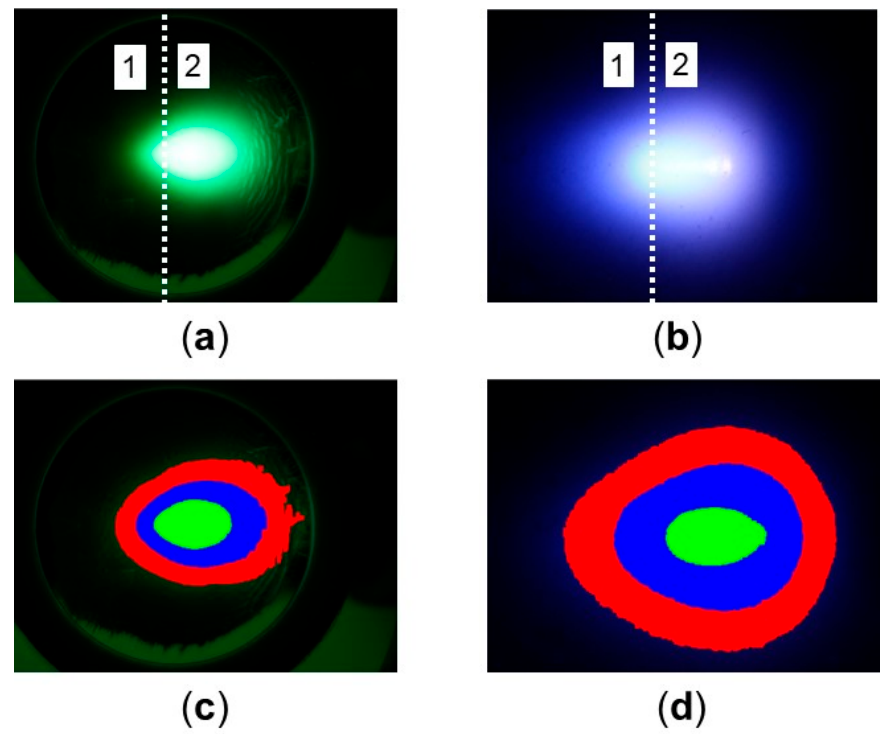
Figure 9. Total e ff ective area depending on incidence angle (0 ◦ , 25 ◦ , 50 ◦ ) after 45 s treatment with Figure 9. Total effective area depending on incidence angle (0°, 25°, 50°) after 45 s treatment with kINPen ® MED- β for the inhibition zone assay ( Staphylococcus aureus DSM 799 / ATCC 6538, M ± SD, kINPen ® MED- β for the inhibition zone assay ( Staphylococcus aureus DSM 799/ATCC 6538, M ± SD, n n = 6) and ROS determination (M ± SD, n = 3). = 6) and ROS determination (M ± SD, n = 3).